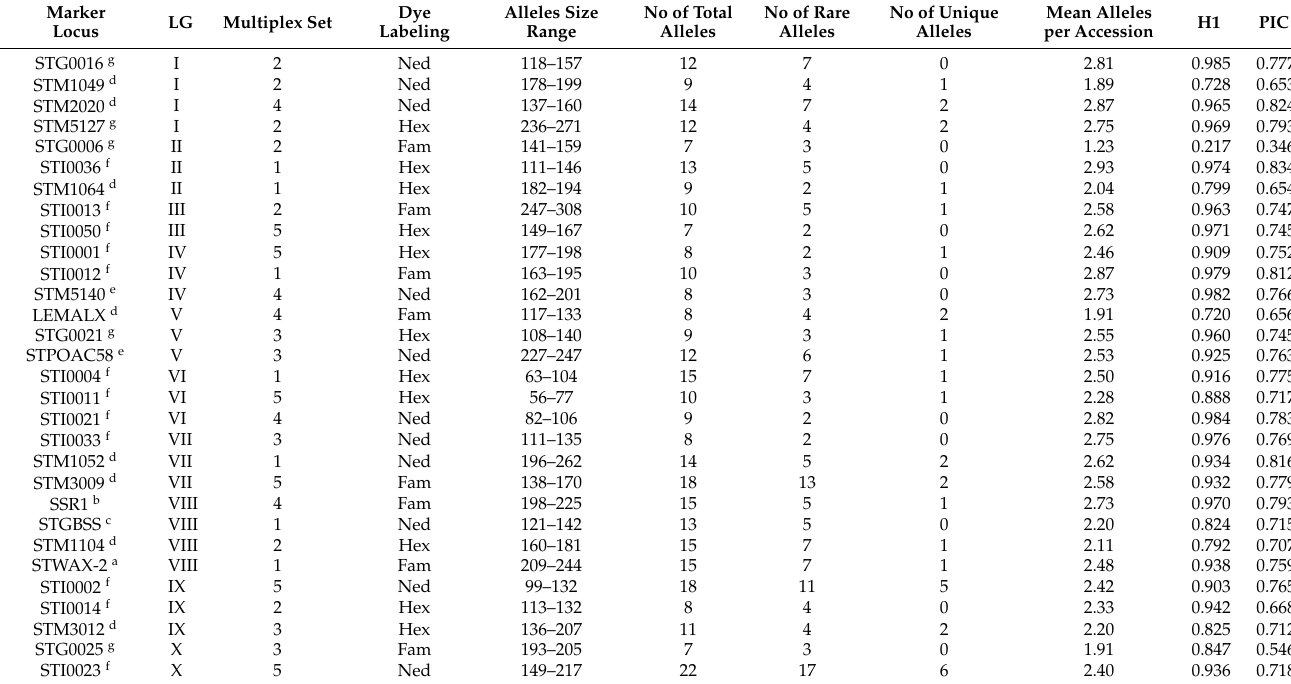
Table 2. Information about the 35 SSR markers used in this study, where the marker locus, linkage group (LG), multiplex set, fluorescent dye labeling, allele size range, number of total, rare, and unique alleles, mean alleles per accession, heterozygosity frequency (H1) and PIC are given based on a panel of 1219 potato